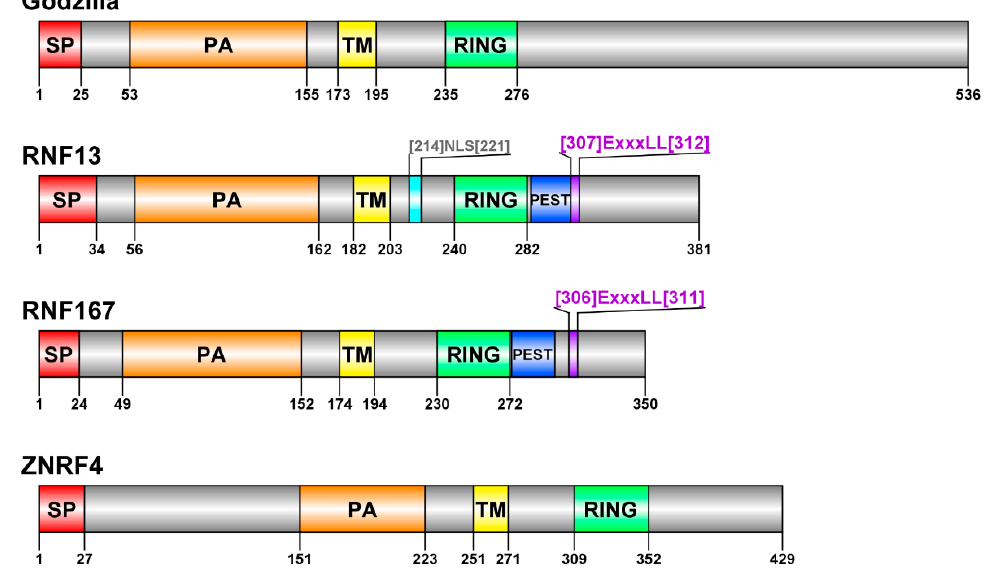
Figure 2. Schematic domain structure of Drosophila Godzilla, human RNF13, human RNF167, and human ZNRF4 proteins. SP, signal peptide (in red); PA, protease-associated domain (in orange); TM, transmembrane domain (in yellow); NLS, nuclear localization signal (in light blue); RING, RING domain (in green); PEST, PEST domain (in deep blue); ExxxLL, dileucine motif (in purple). Graphical representations were generated with DOG 2.0.1: Illustrator of Protein Domain Structures [37].